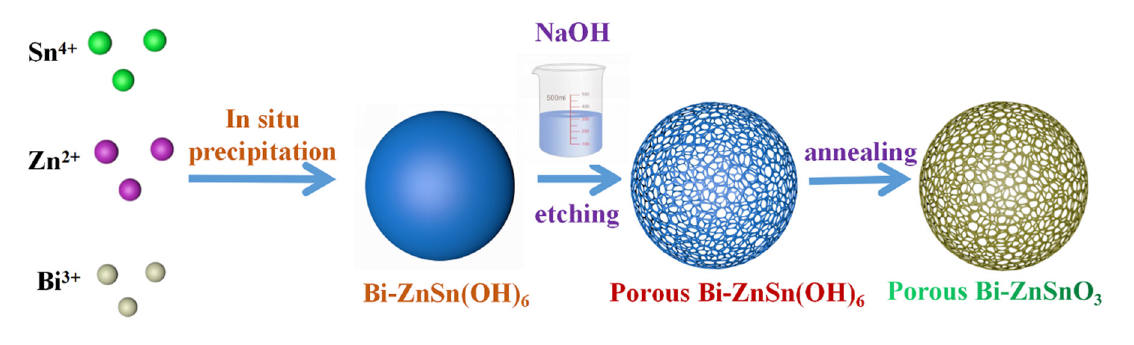
Figure 1. Synthesis process of Bi-ZnSnO 3 composites.